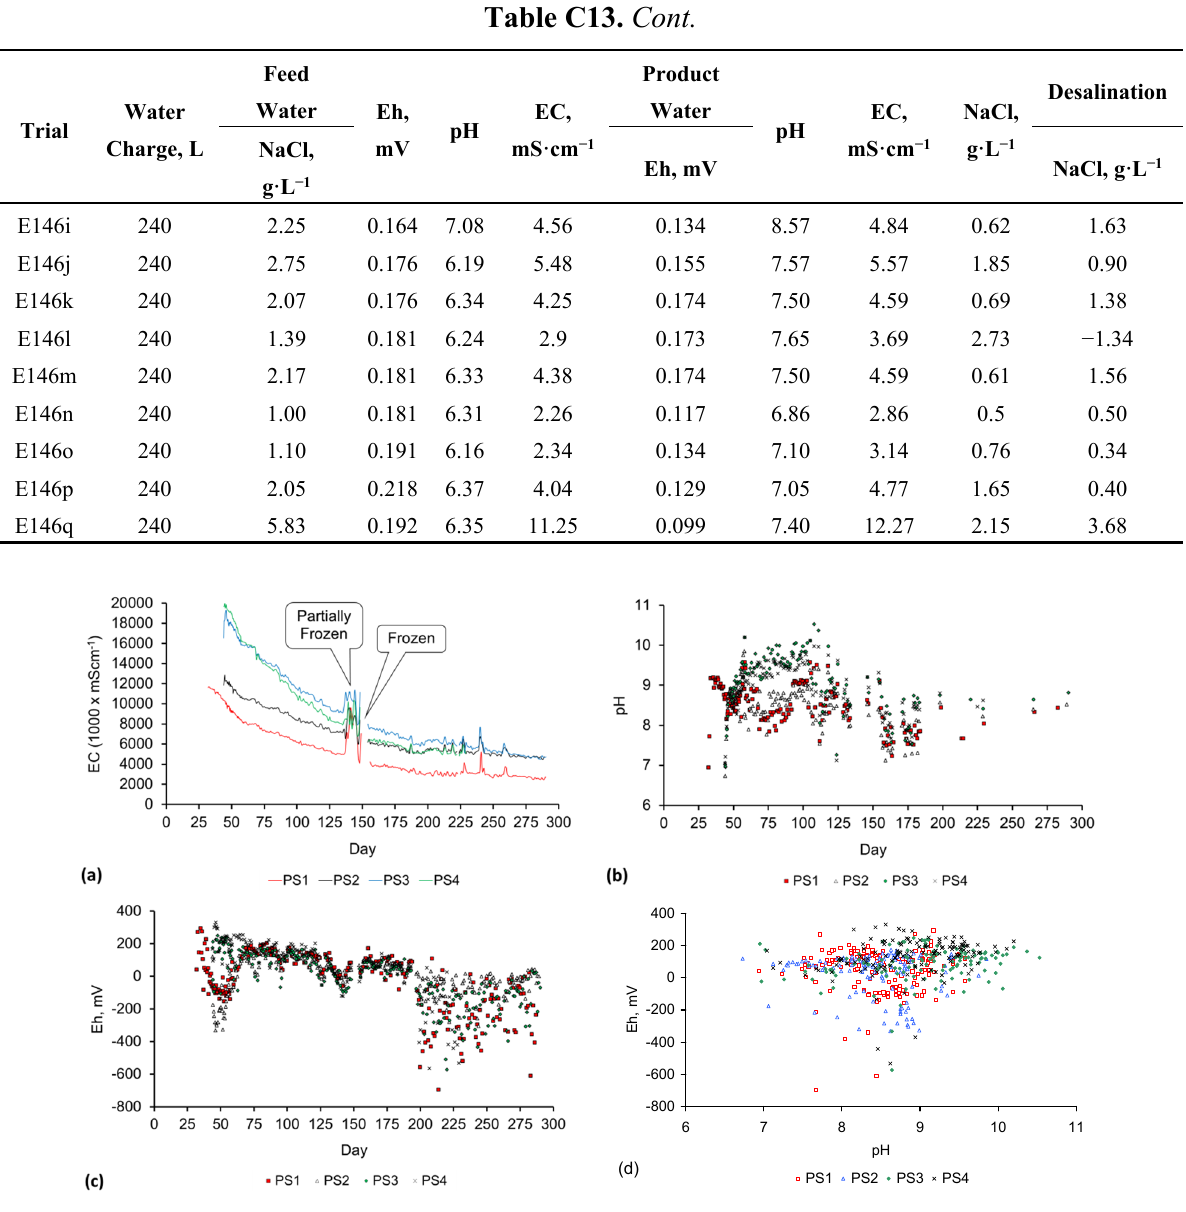
Figure C1. ( a ) EC vs. day; ( b ) Eh vs. day; ( c ) pH vs. day; ( d ) pH vs. Eh. ZVM TP = particulate material placed in water at a concentration of PS1 = 30 g·L − 1 ; PS2 = 30 g·L − 1